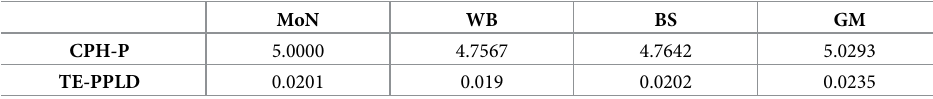
Table 2. Significance thresholds as a function of generating